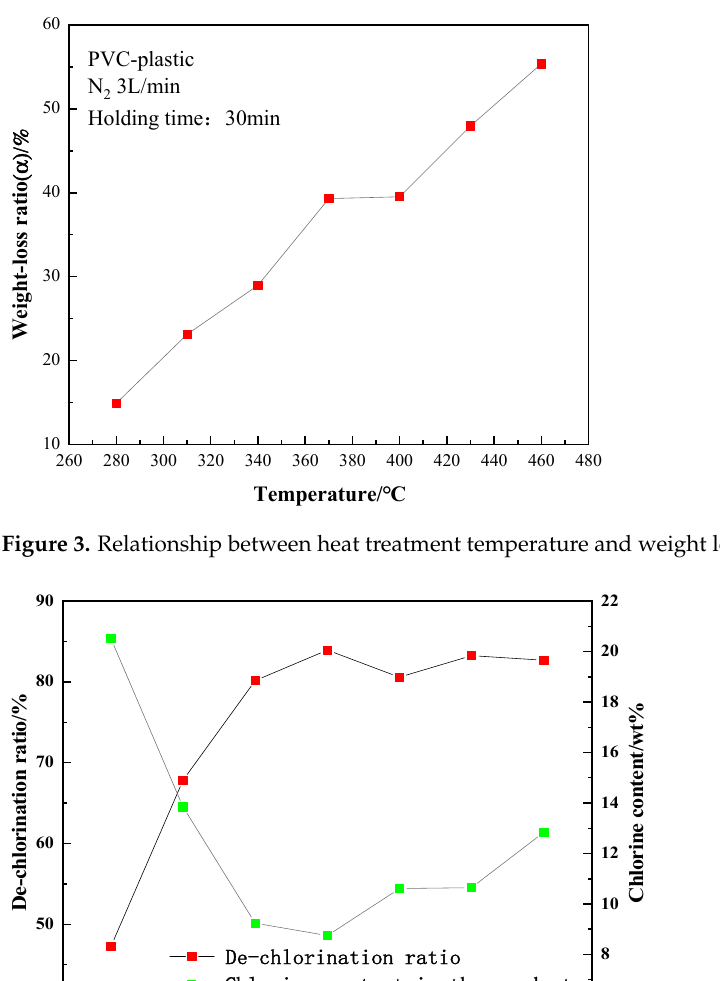
Figure 3. Relationship between heat treatment temperature and weight loss ratio of PVC film.